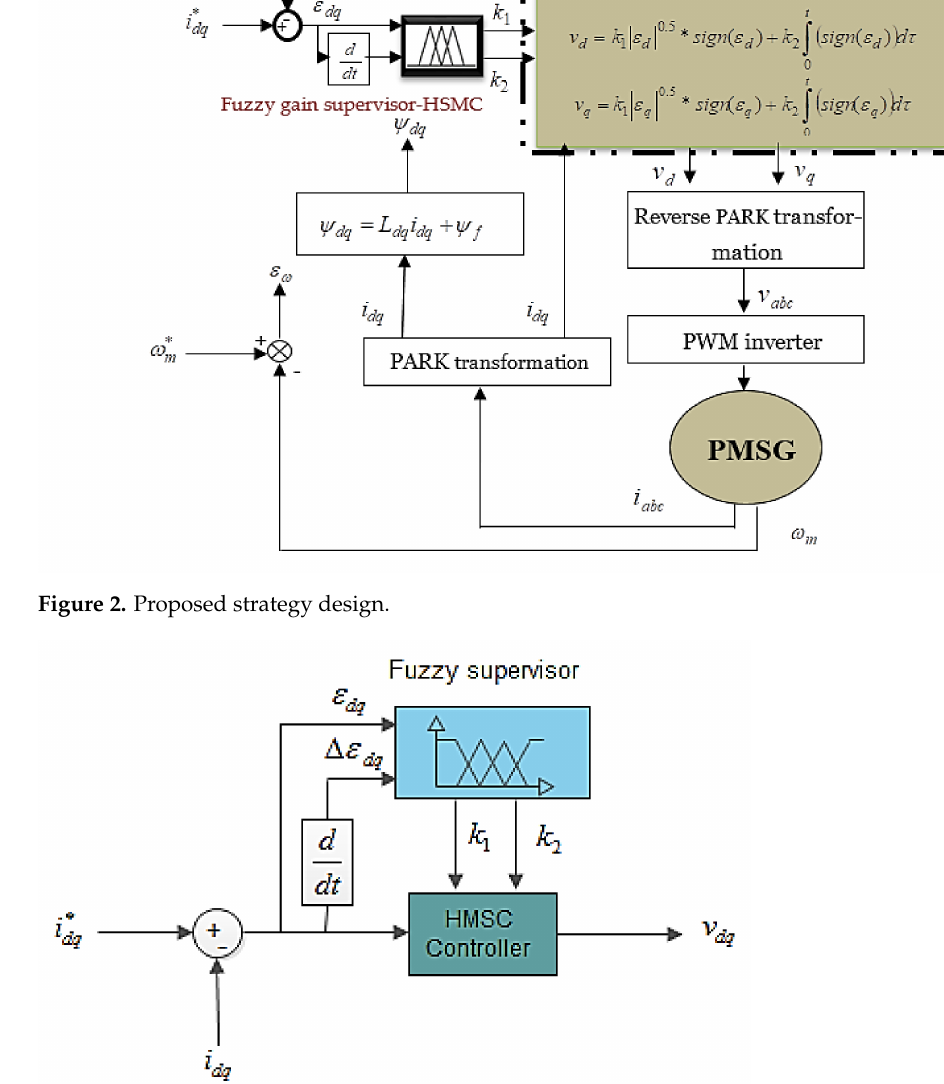
Figure 3. Fuzzy gain supervisory high order sliding-mode controller (HSMC)